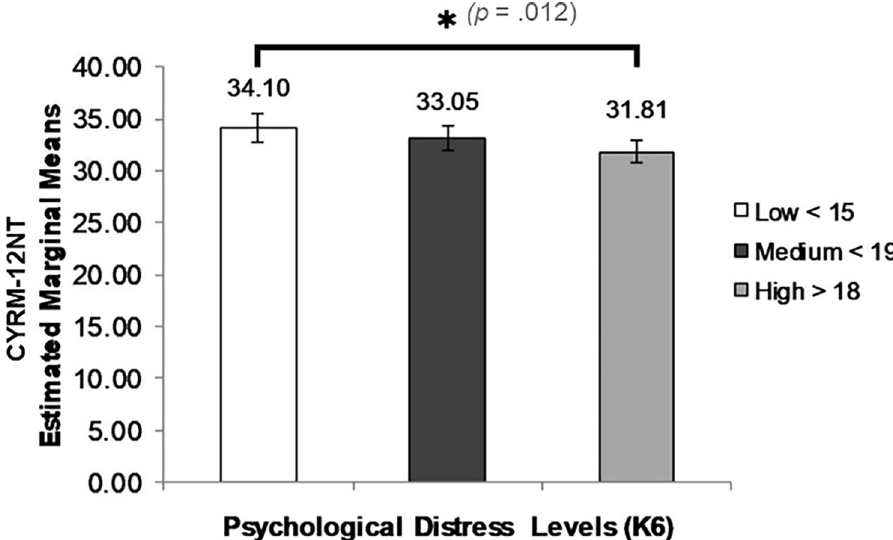
Fig 4. ANOVA results: CYRM-12NT scores by level of psychological distress (K6).